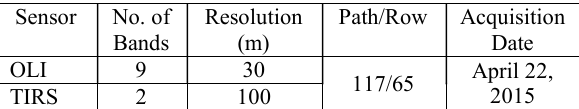
Table 1. Metadata of Satellite